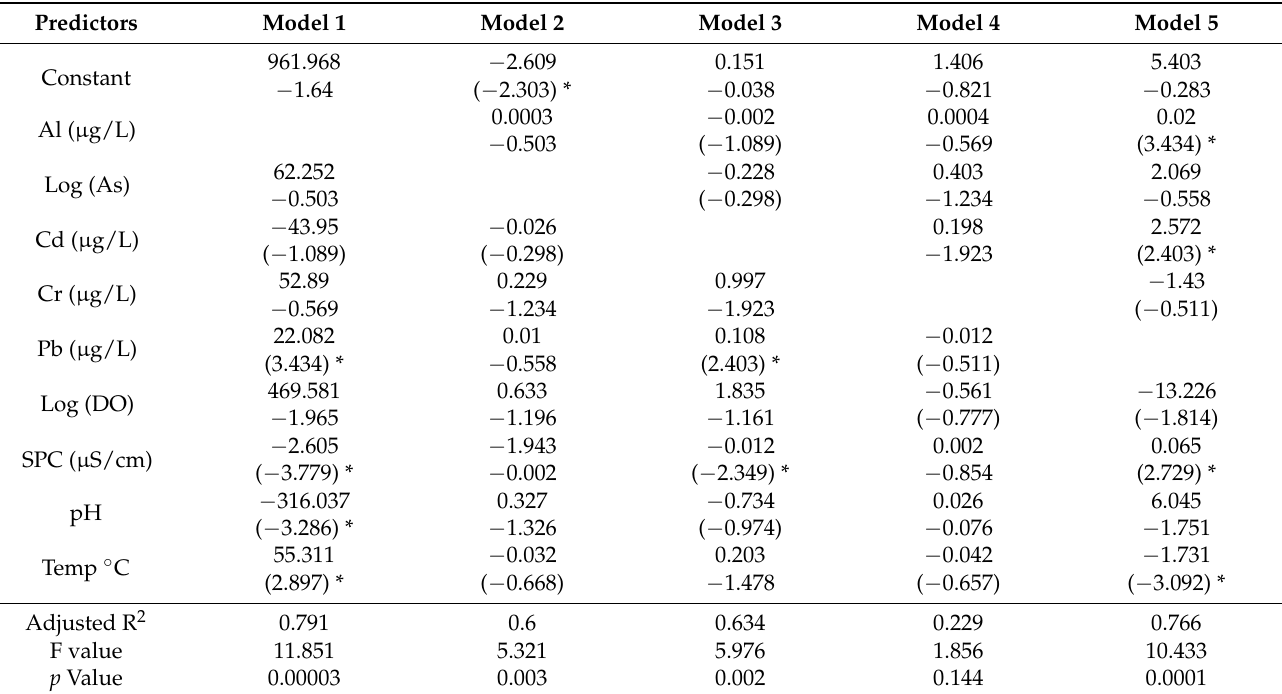
Table 8. Linear regression model for the metal’s concentration in Langat River, Malaysia.